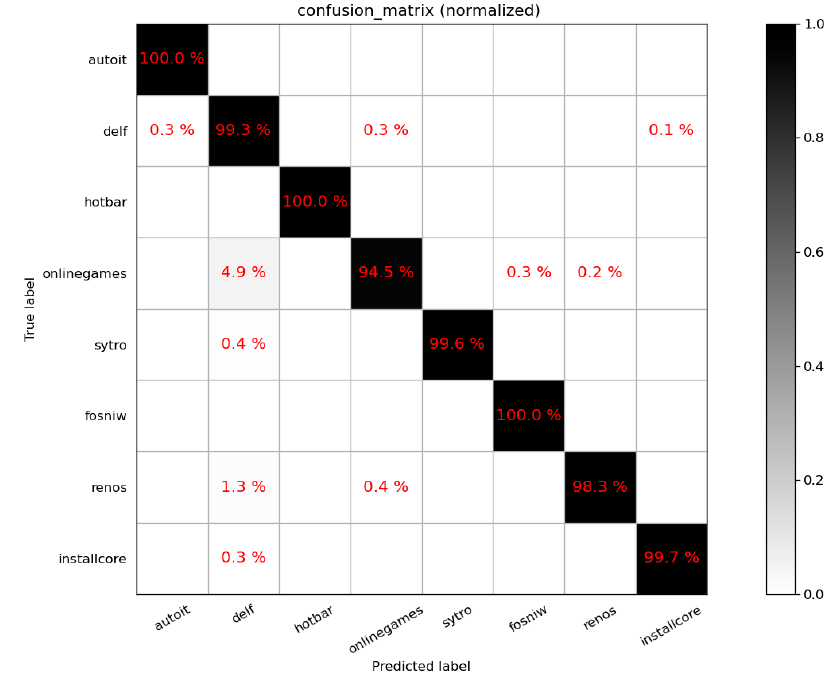
Figure 7. The normalized confusion matrix of the classification result (2).